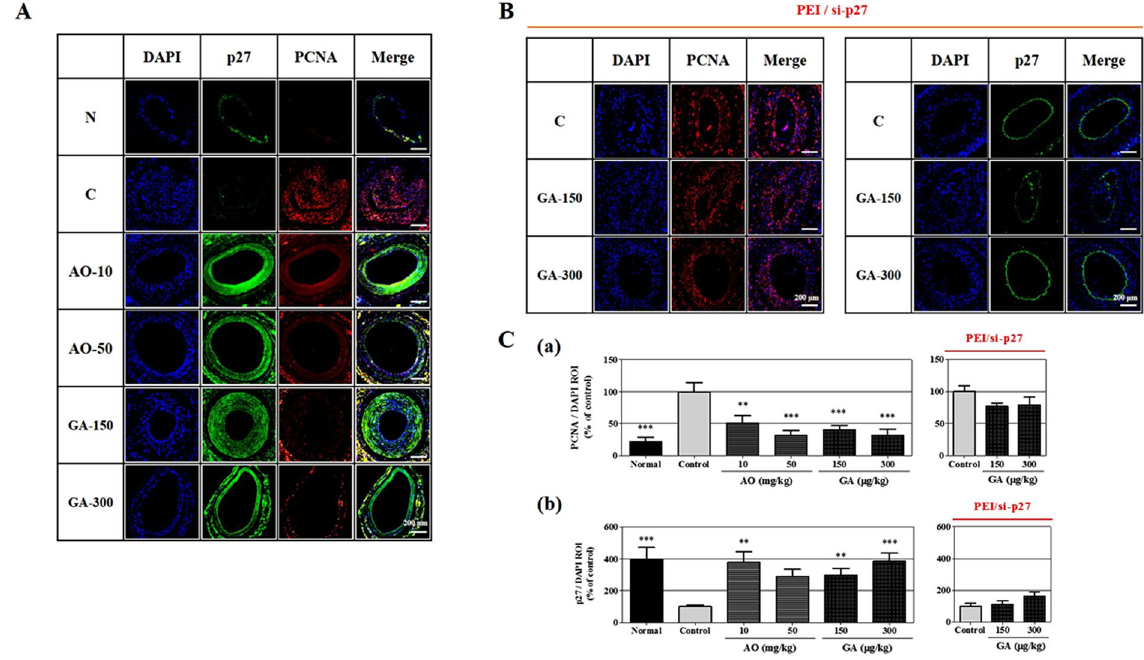
Figure 6. Effects of the AO extract and GA on PCNA and p27 expression in a cuff-injured neointimal hyperplasia model of the femoral artery. The immunofluorescence levels of PCNA and p27 expression were examined in the femoral artery. ( A ) The suppression of PCNA expression and the up-regulation of p27 expression by the AO extract (10 and 50 mg/kg) and GA (150 and 300 μ g/kg) were detected using immunofluorescence staining. ( B ) The effect of silencing p27 expression on the PCNA suppression and p27 up-regulation by GA (150 and 300 μ g/kg). ( C ) Comparison of the fluorescence levels expressed PCNA (a) and p27 (b) as normalized values of DAPI (n = 5). Images are presented at their original magnification (300 × ; A and B ), scale bar is 200 μ m. The values are expressed as the mean ± SEM. Significant differences relative to the cuff- injured control are indicated by asterisks: ** P < 0.01, *** P <